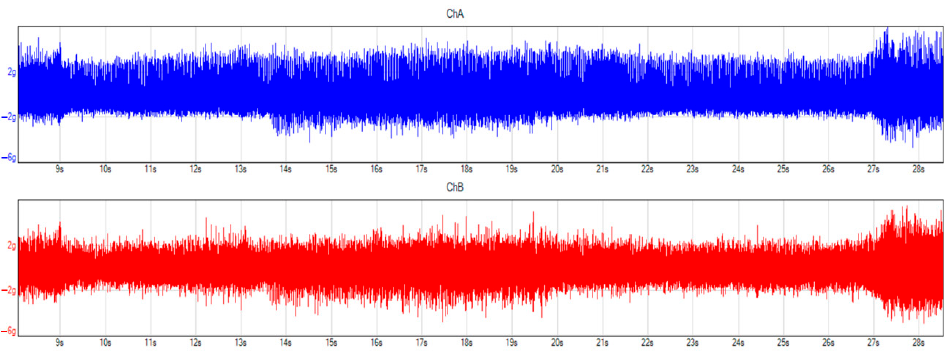
Figure 9. Vibrations in the time domain before the oil change, 0–70 km/h. Blue and red colors mean the different considered and applied channels, during the measurement.